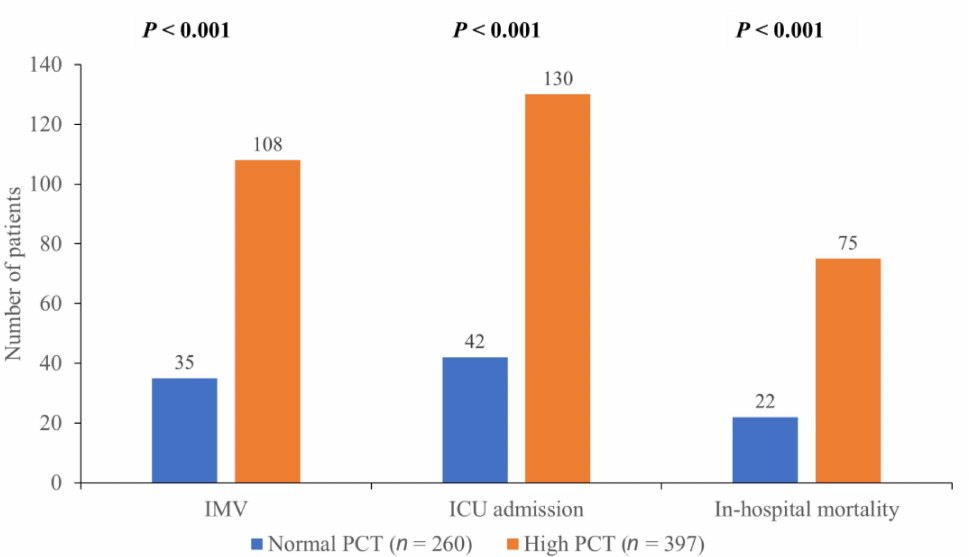
Figure 2. The primary outcomes in the normal and the high PCT groups. Abbreviations: ICU, intensive care unit; IMV, invasive mechanical ventilation; PCT,